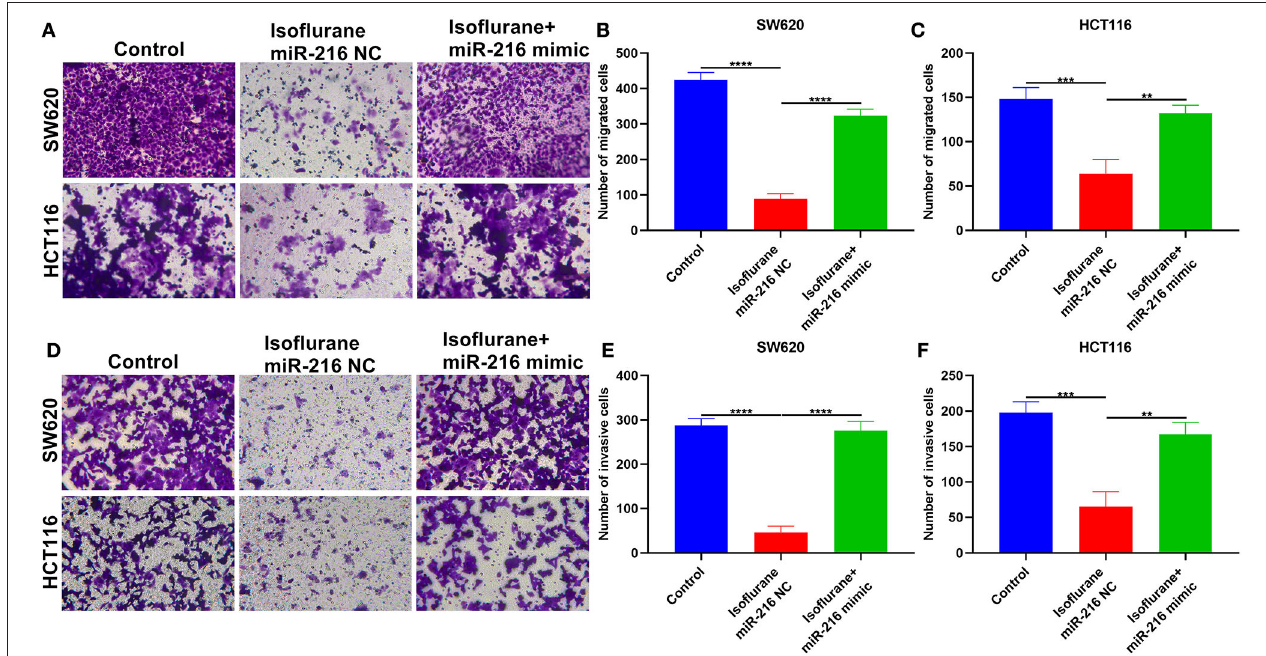
FIGURE 6 | Isoflurane weakens migration and invasion of CRC cells partly through miR-216. (A–C) The number of migrated SW620 and HCT116 cells under exposure to isoflurane and/or miR-216 mimic. (D–F) The number of invasive SW620 and HCT116 cells following treatment with isoflurane and/or miR-216 mimic. ** p < 0.01; *** p < 0.001; **** p <